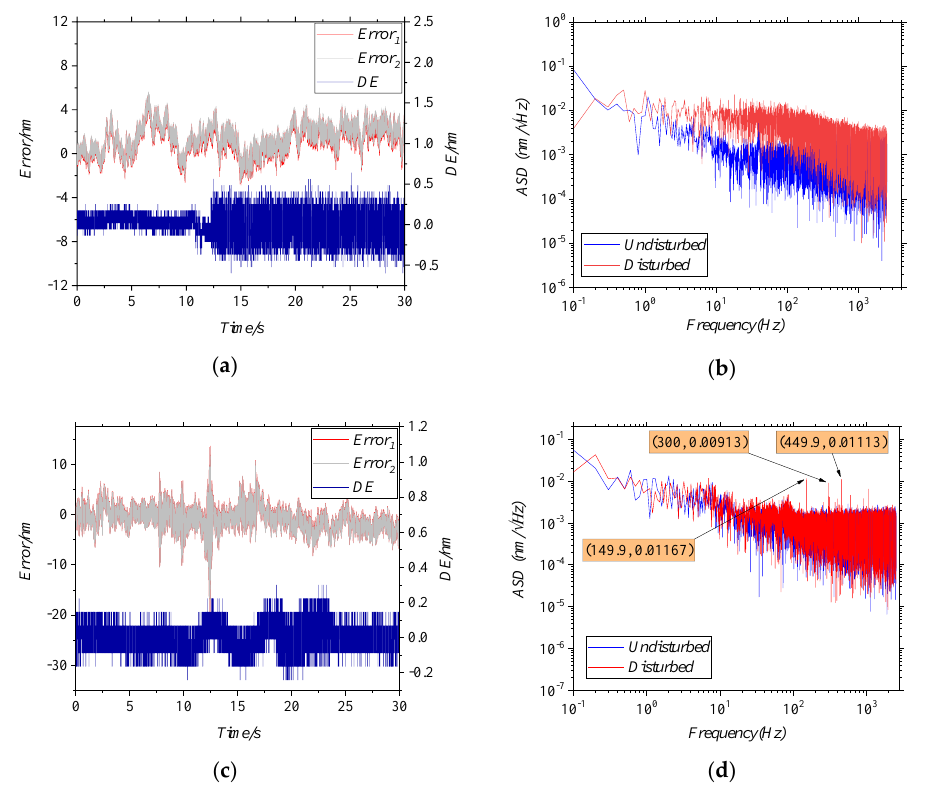
( b , d ) show the ASD of the DE in ( a , c ), respectively. ( a , b ) are the results of the disturbance by the hands. ( c , d ) are the results of the disturbance by the